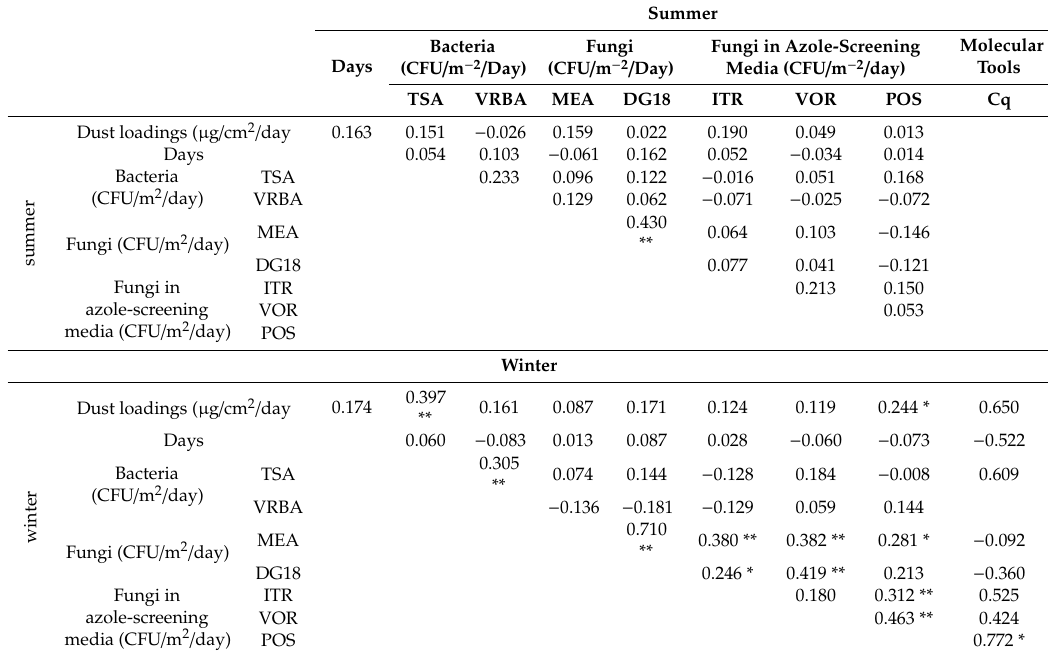
Table 10. Relationships between bacterial counts, fungal counts (MEA and DG18), azole resistance (itraconazole (ITR), voriconazole (VOR), and posaconazole (POS) media), and molecular tools (Cq) established by Spearman correlations.